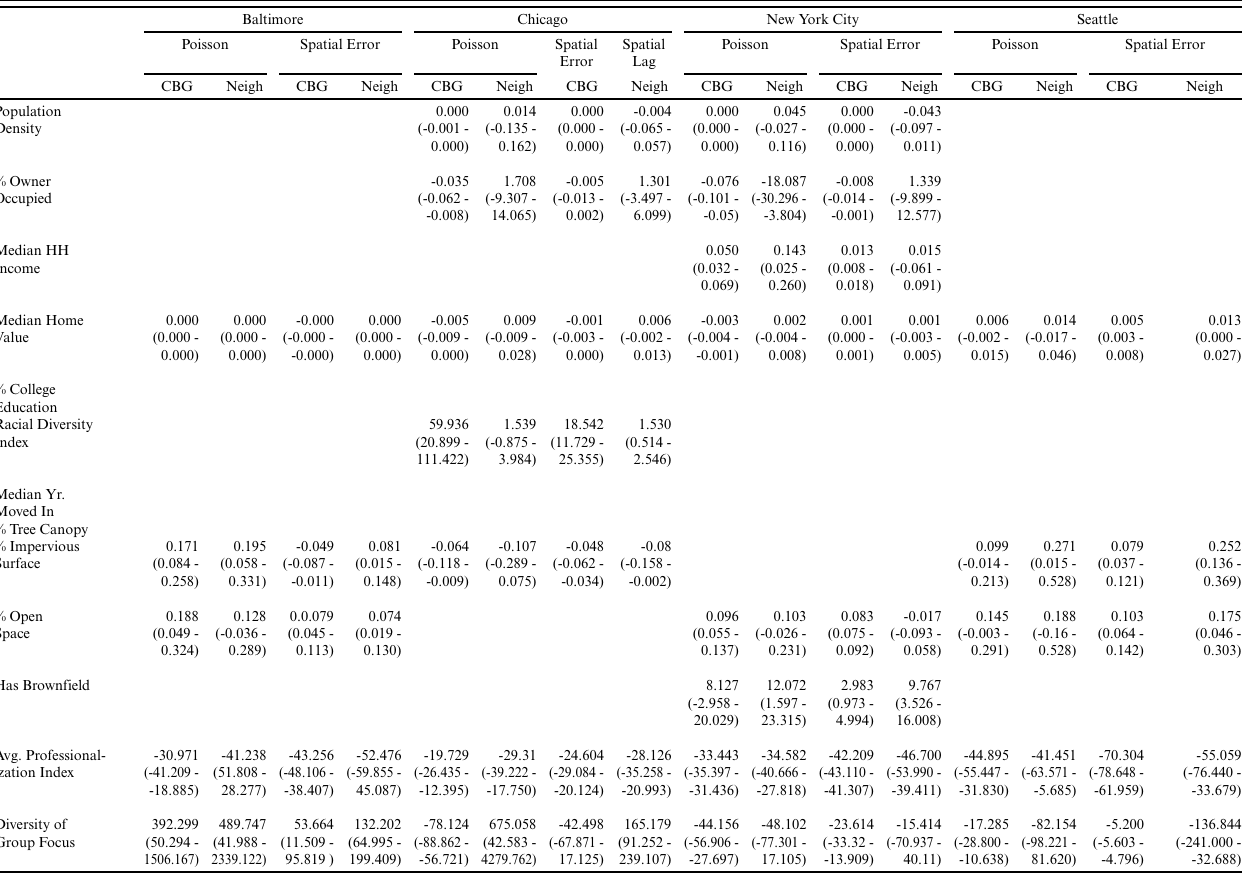
Table 6 . Comparative marginal effects (percent change) by model to number of environmental stewardship groups. All values for a one unit or category marginal change unless otherwise